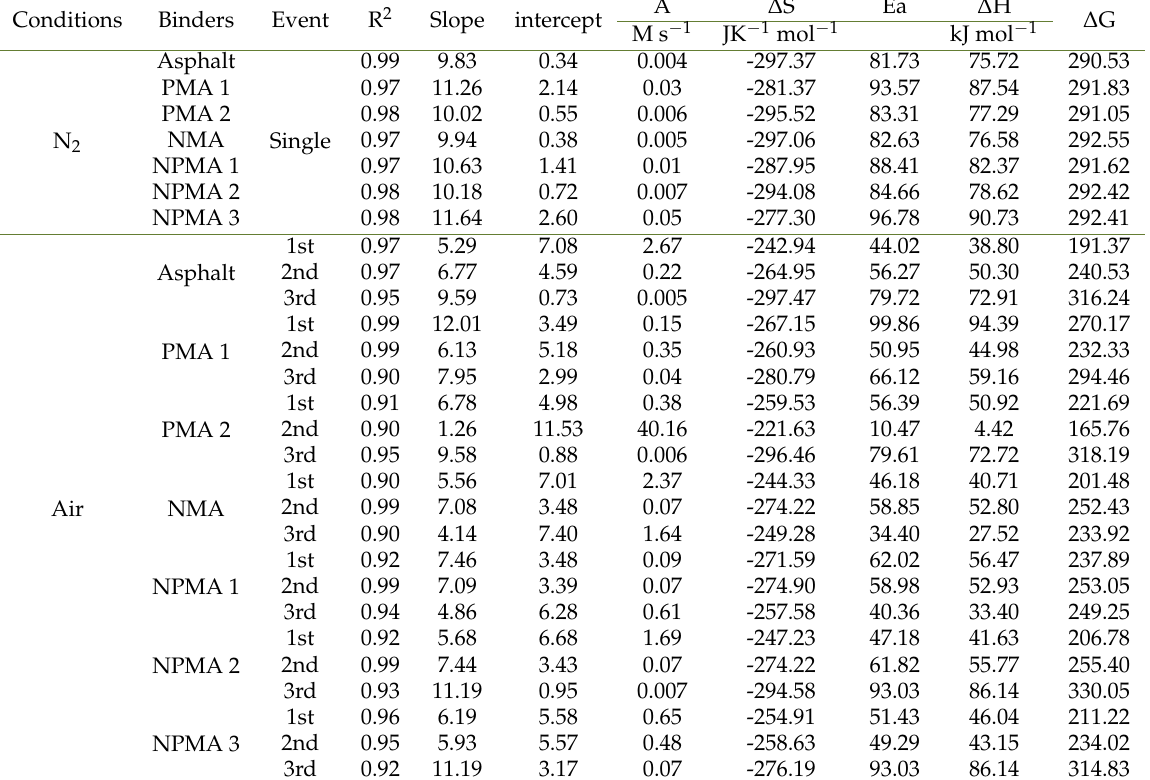
Table 6. Kinetic and thermodynamic parameters of each asphalt